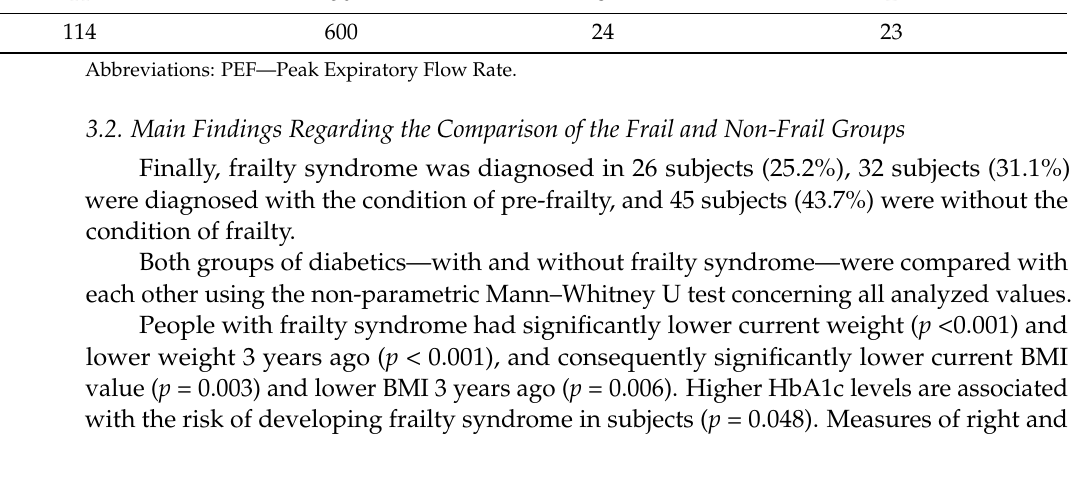
Abbreviations: PEF—Peak Expiratory Flow